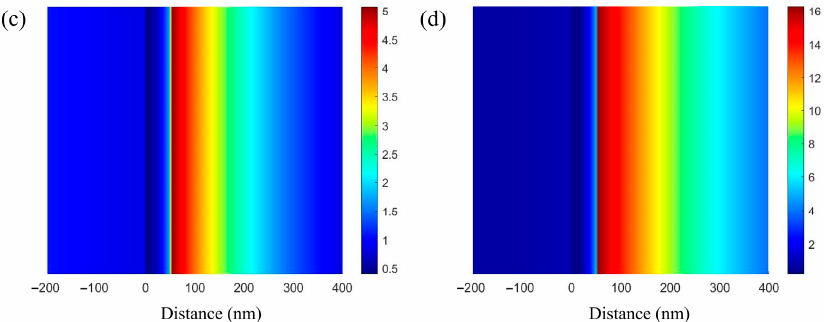
Figure 4. The electric field distributions for ( a , c ) conventional Au-based sensor and ( b , d ) graphene– MoS 2 hybrid-structure sensor.